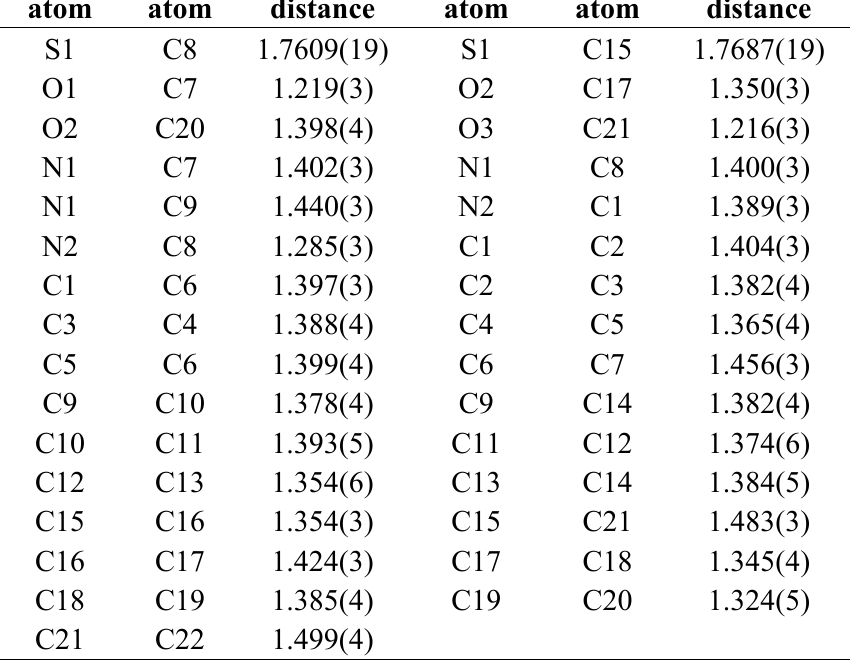
Table 10. Bond lengths (Å) for compound 10 .